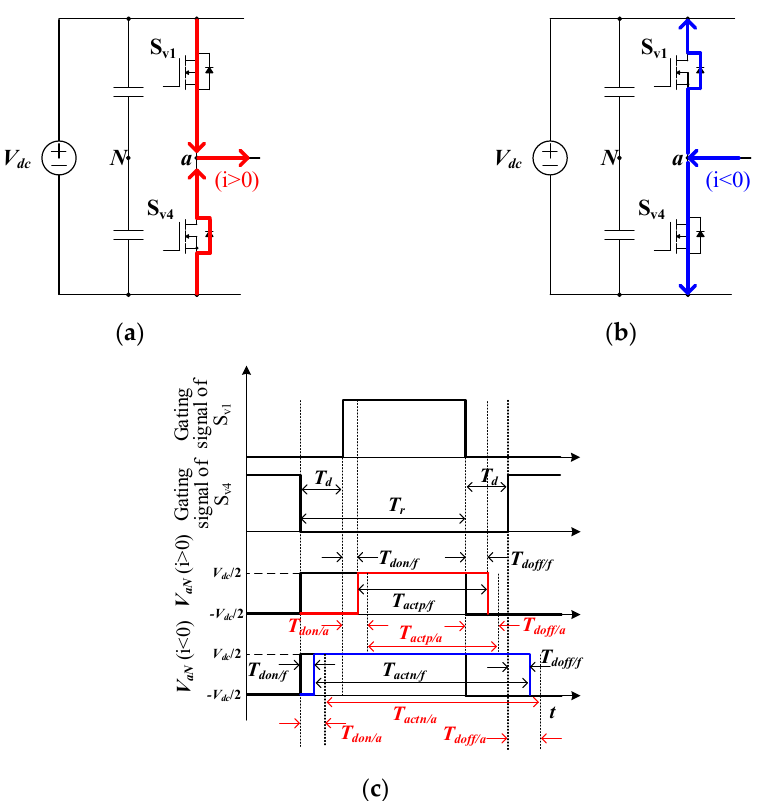
Figure 26. Gating signals of S v1 and S v4 considering dead time, T don , and T doff . Figure 26. Current path and gating signals of S v1 and S v4 considering dead time, T don , and T doff . ( a ) current path in i > 0 ( b ) current path in i < 0 ( c ) gating signals of S v1 and S v4